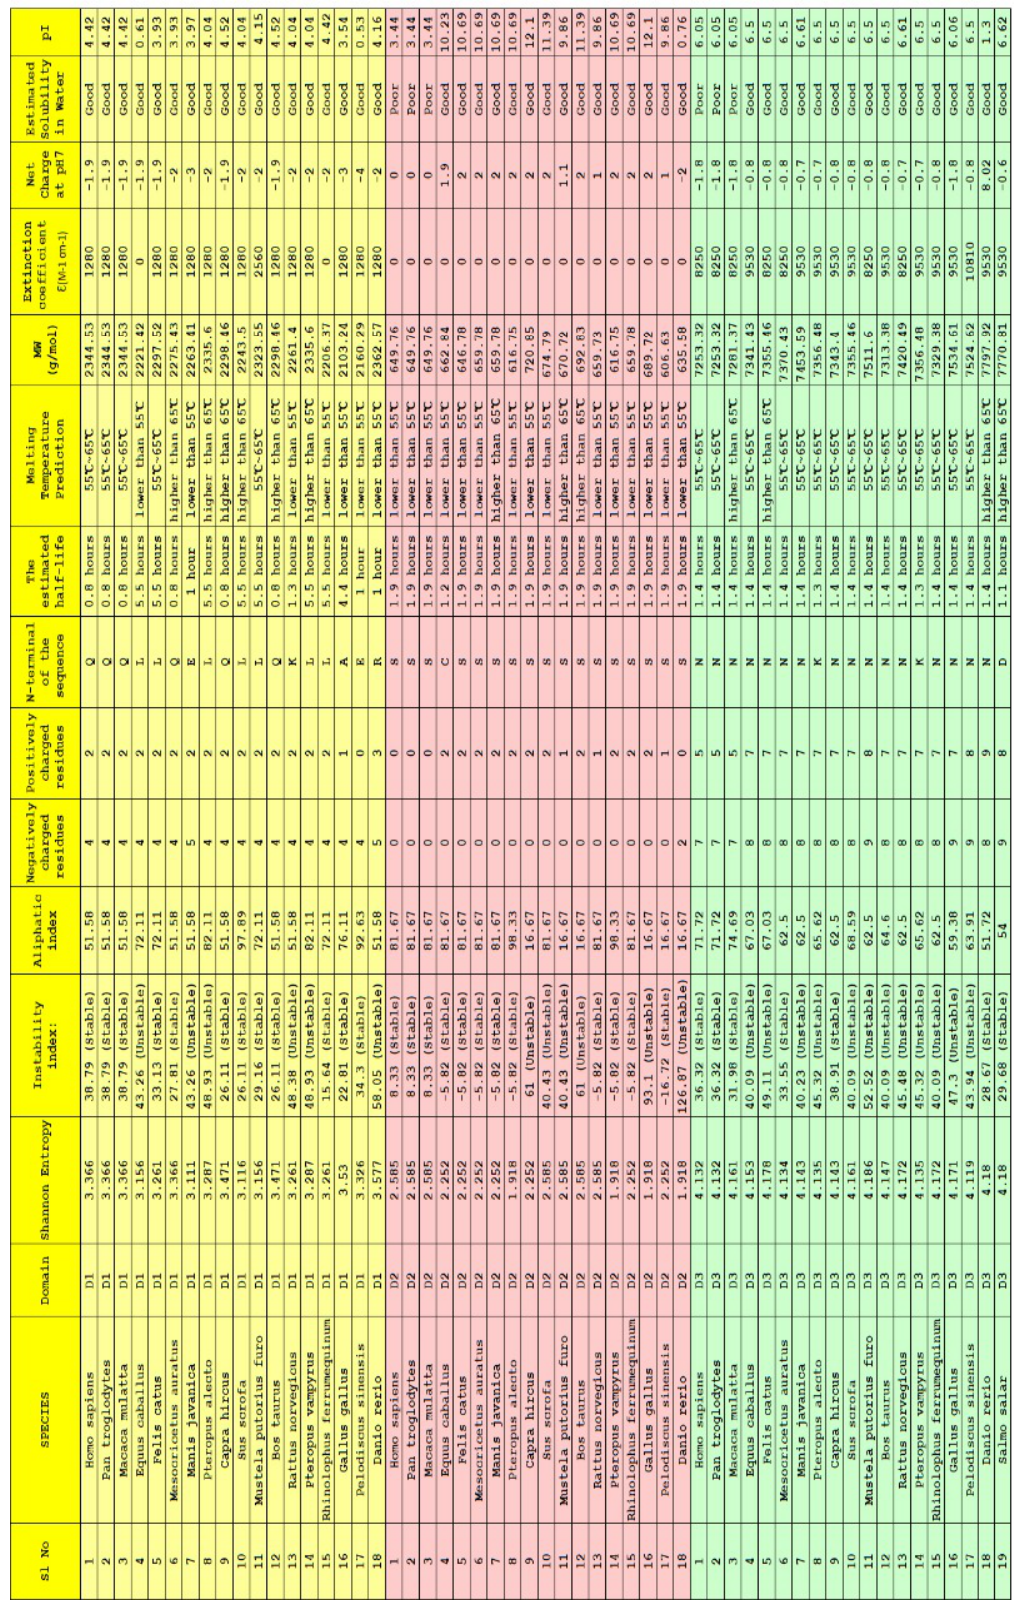
Figure 6. Bioinformatics of the D1, D2, and D3 domains of ACE2 from eighteen species. For Salmo salar , only D3 bioinformatics was